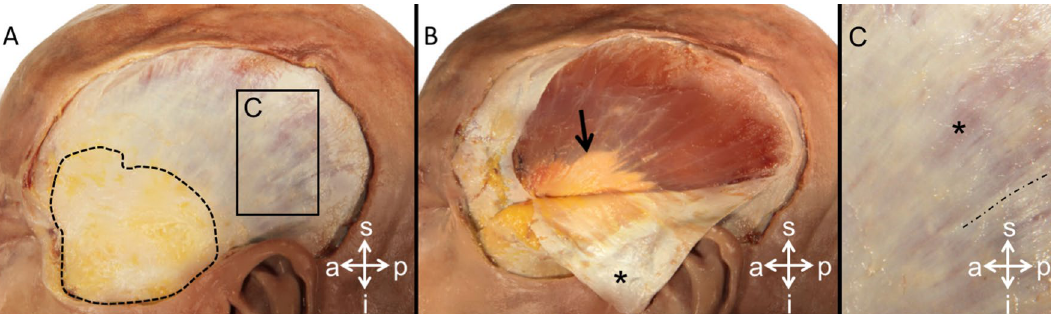
Figure 1. Temporal muscle fascia (TMF) of the left temporal area has been dissected in a body donor of the Department of Anatomy, University of Otago, Dunedin, New Zealand. ( A ) The superficial layer of the deep TMF becomes visible after the temporal skin and subcutaneous fat have been resected. The dotted line outlines the superficial temporal fat pad. The black rectangle represents the section of the TMF shown in ( C ). ( B ) The TMF was dissected from the underlying temporal muscle and then flipped for the inner surface of the fascia (asterisk) to become visible. Note that the inner surface of the fascia reveals a streaky pattern, indicating mechanical tissue anisotropy. The black arrow points at the temporal muscle tendon. ( C ) The anisotropic organization of the TMF can be observed in more detail. The size of the depicted image is represented by a black outlined rectangle in A. The TMF has a striated appearance with more evident areas formed by jointly- running collagen fibres over a longer distance (indicated by the dotted line) and some spot-like transparent areas (asterisk), where the temporal muscle is visible and the striated pattern is less prominent. The samples in this study were tested along the preferred collagen orientation as indicated by the dog bone shape. s, superior; i, inferior; a, anterior; p, posterior.